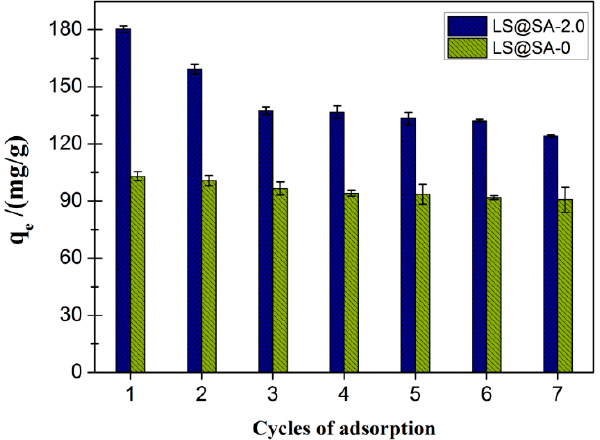
Figure 8. Relationship between the time for reuse and the adsorption capacity for MB. Adsorption experiments, C 0 : 500 mg/L; pH: 6.50; equilibrium time: 600 min.